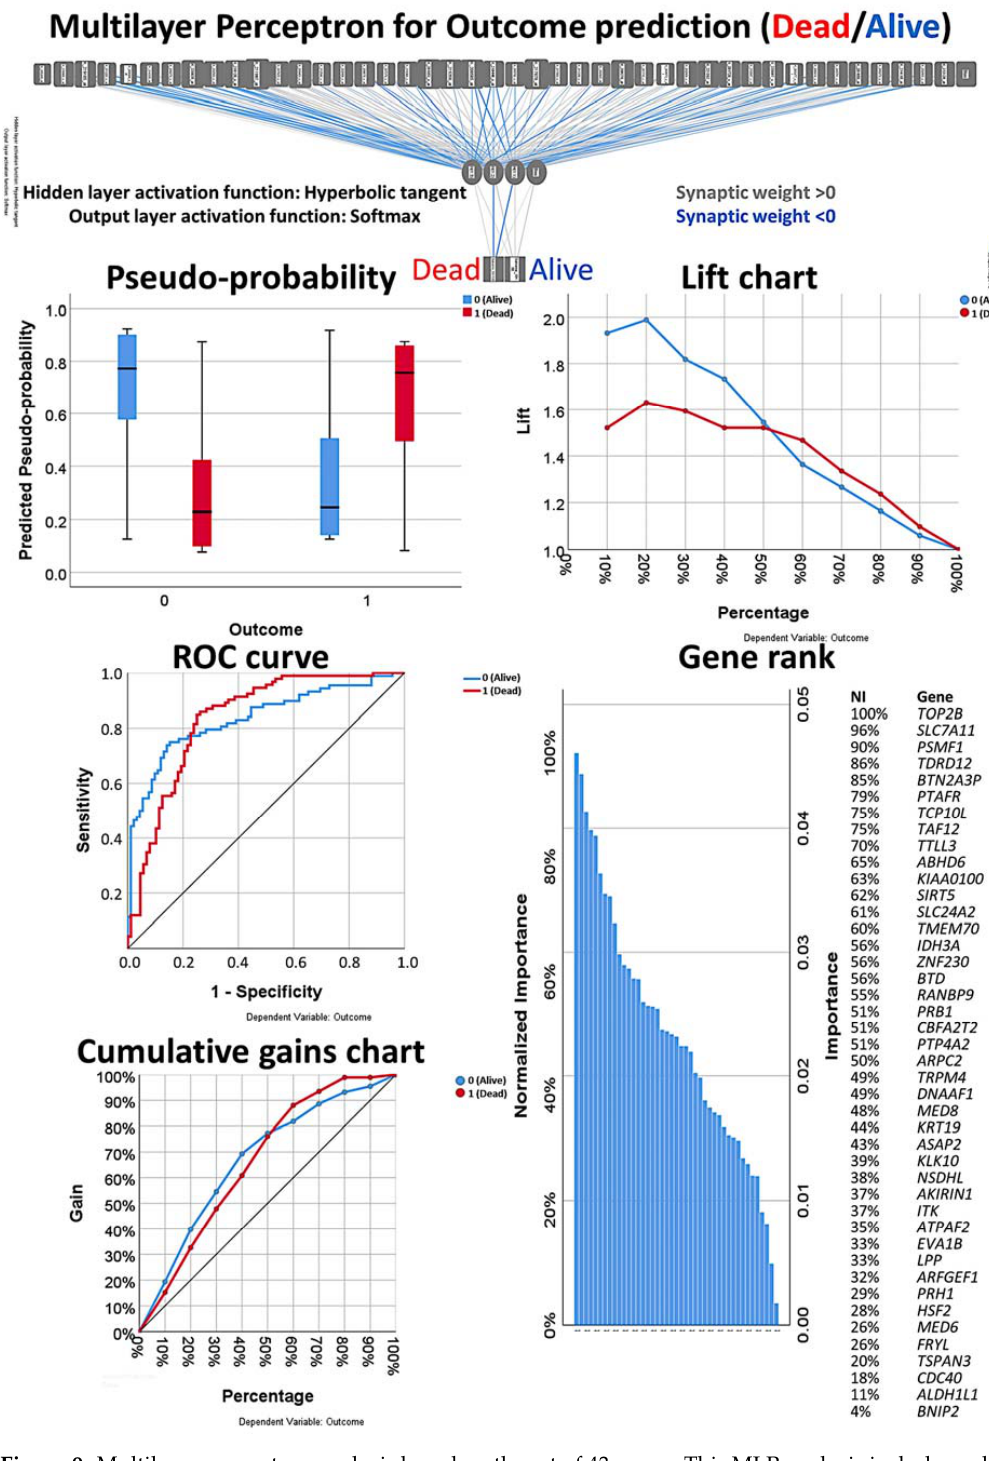
Figure 9. Multilayer perceptron analysis based on the set of 43 genes. This MLP analysis includes only the final set of 43 genes as input variables and predicts the survival of the patients based on the survival outcome (dead / alive). The quality of the neural network analysis can be confirmed with the receiver operating characteristic (ROC) curve, and the rank of the genes is shown according to their normalized importance for